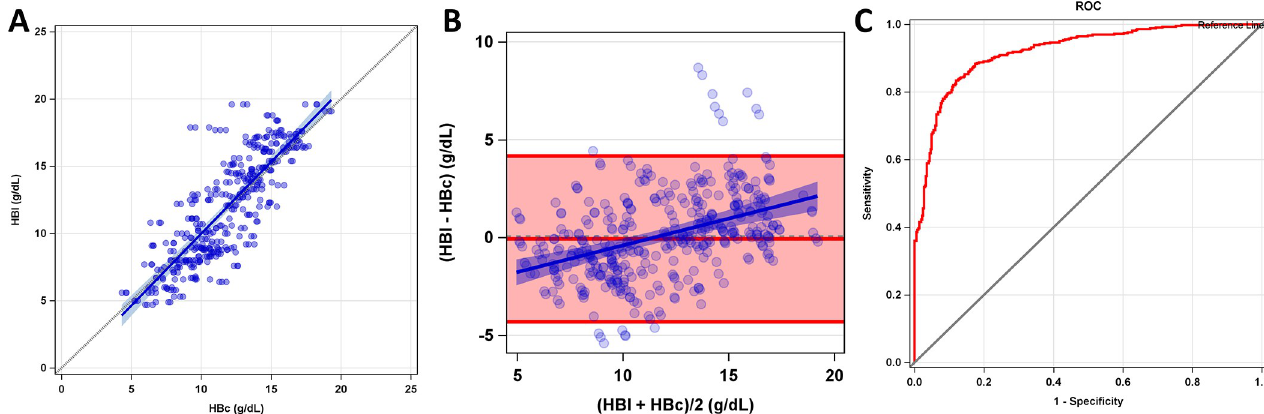
Fig 3. Phase 1 algorithm derivation study results. (A) Correlation (identity) plot of HBc and HBl across 142 participants, (B) Bland-Altman plot shows a bias of 0.10 and limits of agreement of -4.21 to 4.42 g/dL, and (C) Receiver Operator Characteristics of HBc using HBl as the gold standard in gender-specific anemia threshold testing. The x-axis depicts 1- Specificity and the y-axis shows the sensitivity. The red line represents the ROC and the black line is the no- discrimination line. Area Under the Curve (AUC) = 92.1.